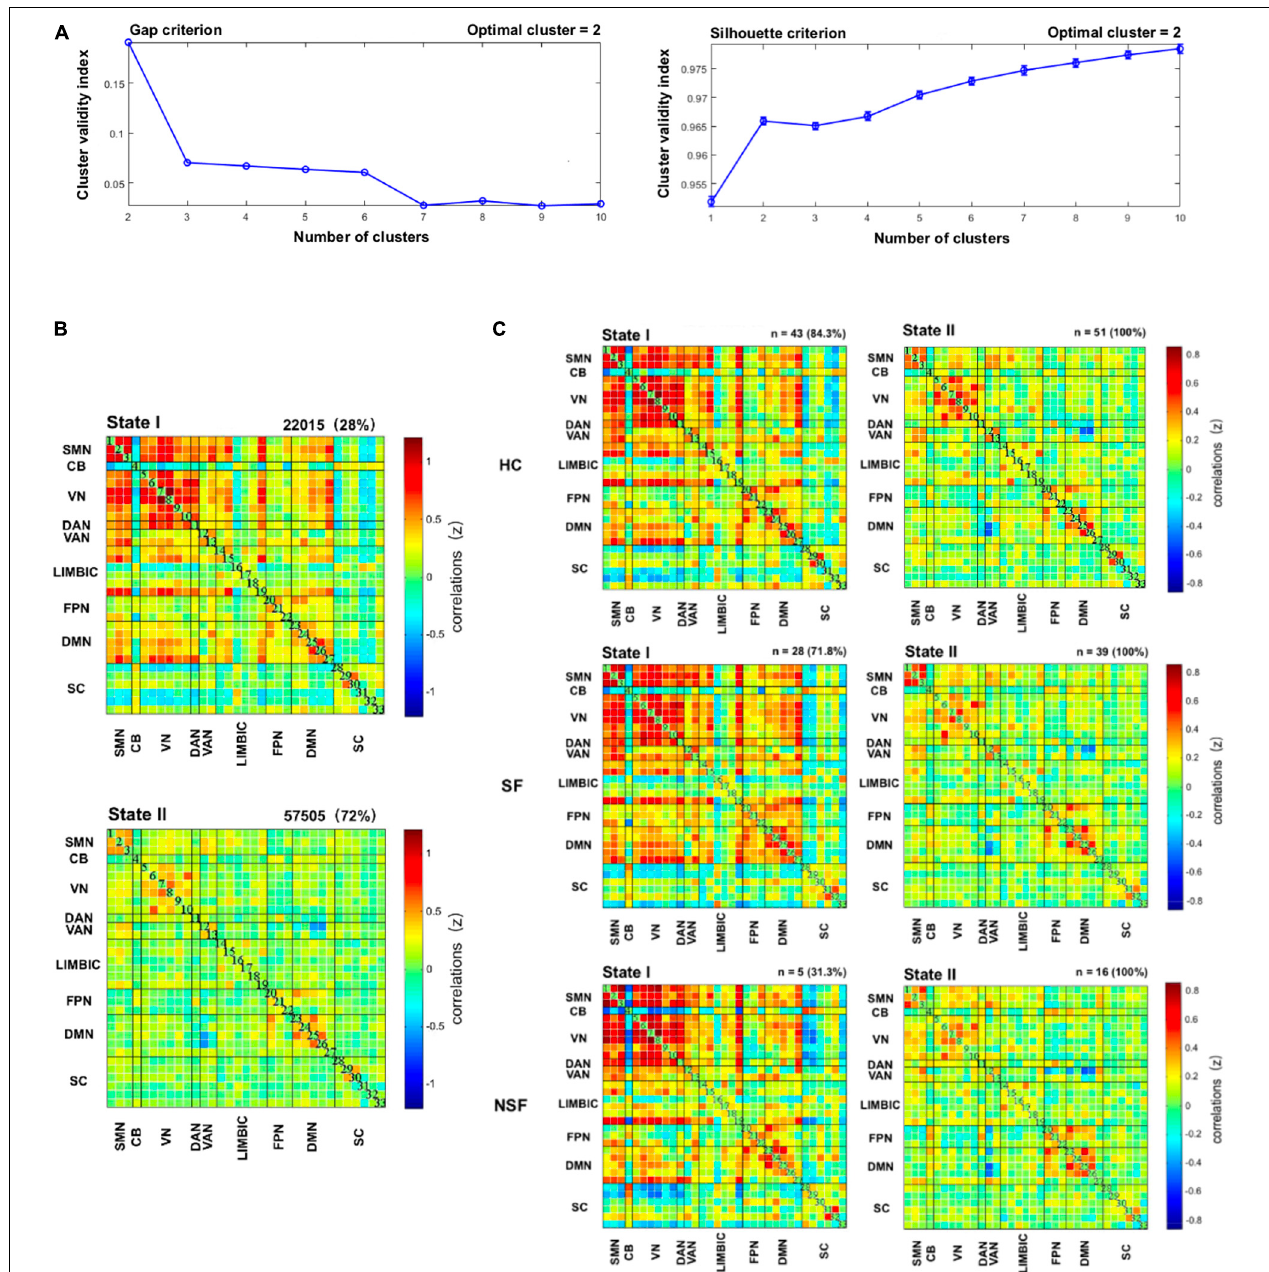
FIGURE 2 | Results of clustering analysis. (A) Gap criterion: the optimal number of clusters as equal to two ( k = 2); Silhouette criterion: the optimal number of clusters equal to 2 ( k = 2). The clustering algorithm was applied to all participants. (B) Cluster medians matrices for each state. The total number and percentage of occurrences are listed upper each cluster right corner. (C) Dynamic functional network connectivity states for each of the three subgroups. CB, cerebellum; DAN, dorsal attention network; DMN, default mode network; FPN, frontoparietal network; HC, healthy controls; LIM, limbic; NSF, not seizure-free; SC, subcutaneous; SF, seizure-free; SMN, sensorimotor network; VAN, ventral attention network; VN, visual